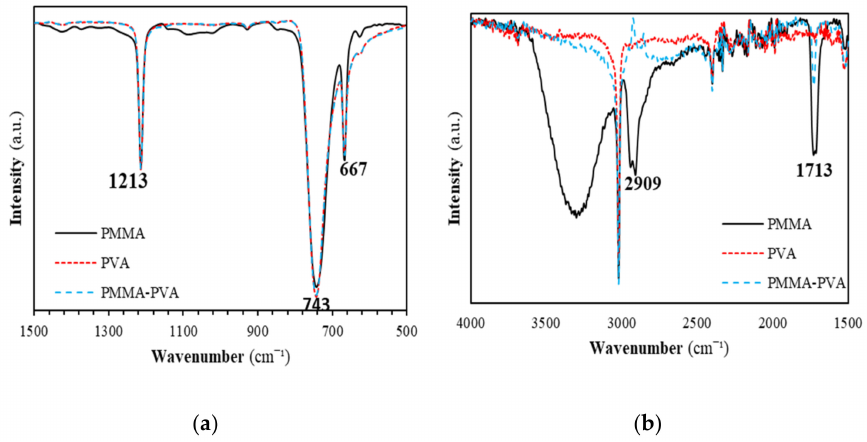
Figure 16. FTIR spectra of PMMA–PVA polymeric thin films in the spectral range ( a ) 500–1500 cm − 1 and ( b ) 1500–4000 cm − 1